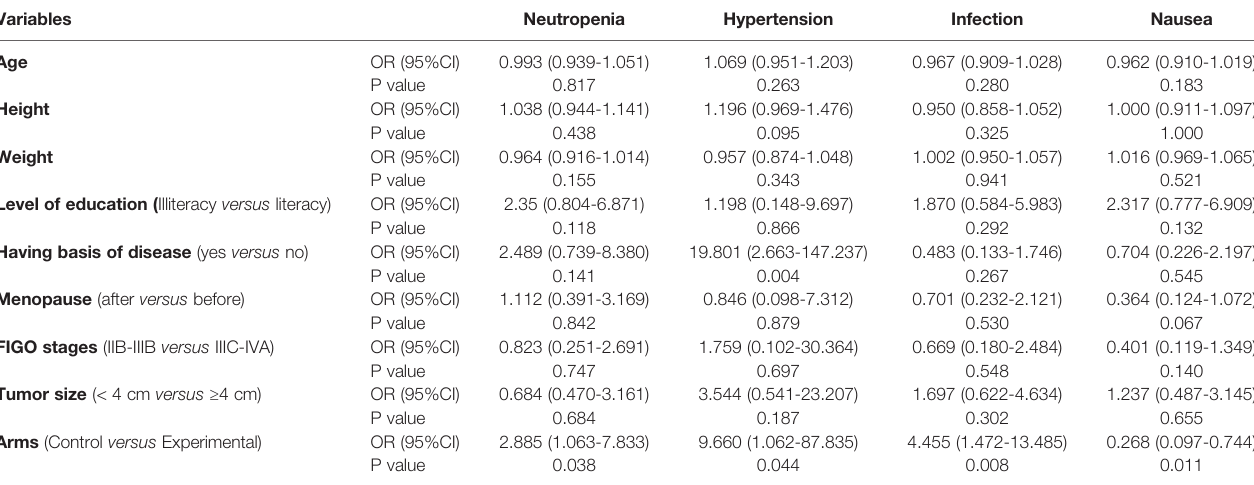
TABLE 4 | The adjusted odds ratios through multivariate regression for clarifying the correlation between toxicological reactions and